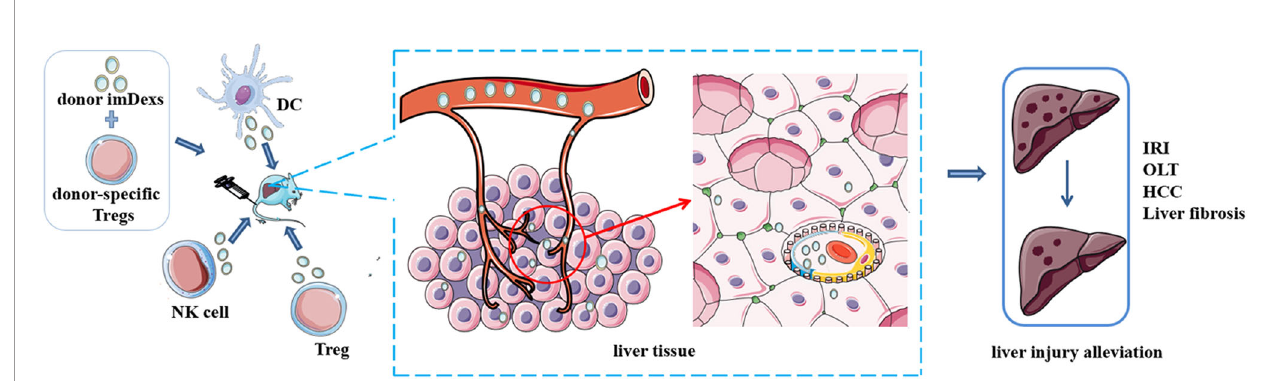
FIGURE 3 | Potential of immune cell-derived exosomes in therapy. Administration of exosomes from some immune cells with or without other treatments alleviate disease condition in mice, such as ischemia/reperfusion injury, liver fi brosis and hepatocellular carcinoma. These results indicate the potential value of immune cell derived exosomes in